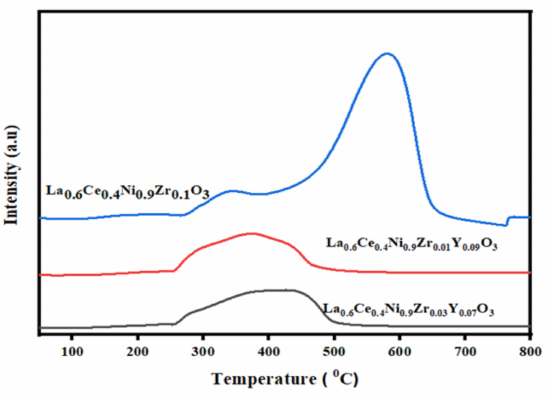
Figure 3. H 2 -TPR profiles of catalyst MNi 0.9 Zr 0.1 O 3 (M = La, Ce, and Cs).